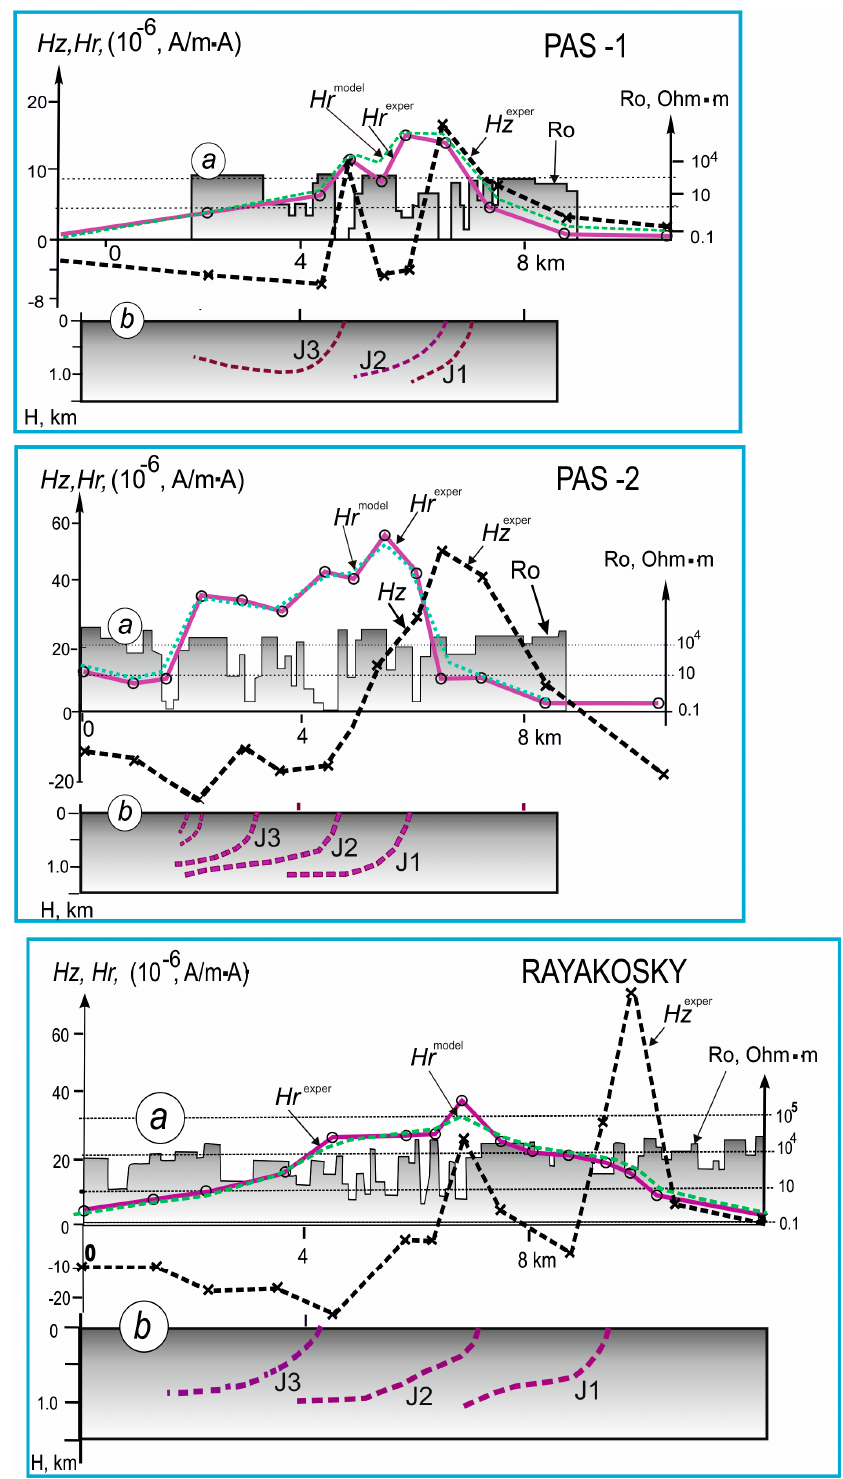
Figure 6. Results of the study of conductive layers of the Pechenga structure’s Western flank by profiles PAS-1, PAS-2 andRayakosky. Location of profilesis shown in Figures 4 and 5. Letters in circles: a— graphs of resistivity Ro from DC electrical profiling and graphs of measured horizontal Hr meas andvertical Hz meas magnetic field from MHD “Khibiny” dipole and modeled horizontal magnetic field Hr model ; b— the deep sections of conductive layers from the results of 2D digital modeling. J 1, J 2 and J 3 — current conductive channels shown on Figures 5 and 6.